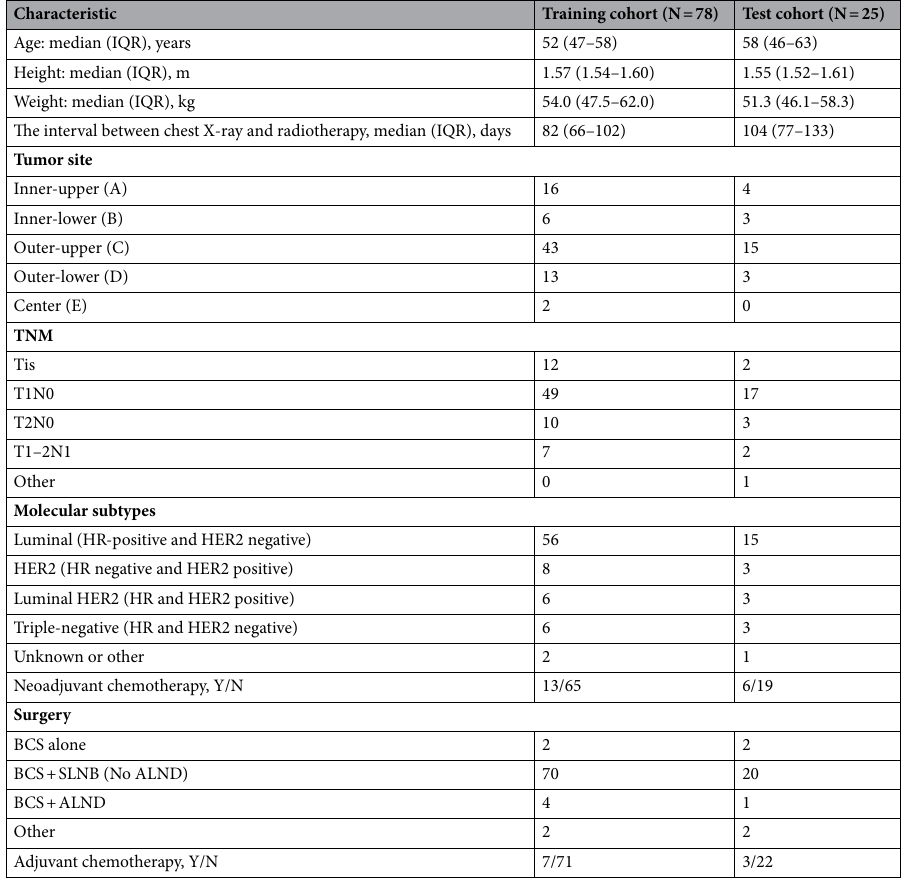
Table 2. Patient characteristics. BCS breast-conserving surgery, SLNB sentinel lymph node biopsy, ALND axillary lymph node dissection, IQR interquartile